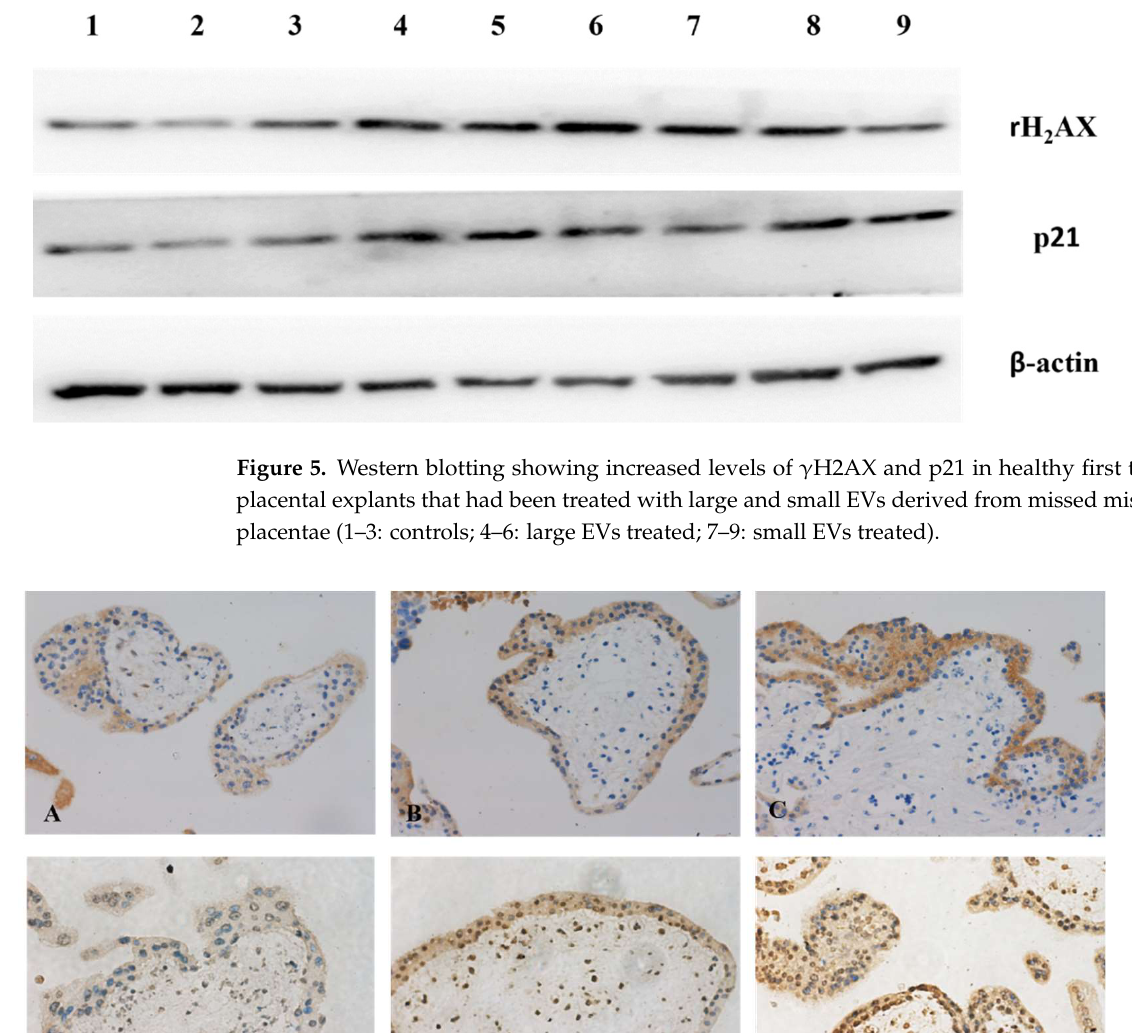
10 of 15 Figure 4. ( A – G ): The levels of senescence-associated miRNAs in missed miscarriage placentae (data represents mean ± SD with five repeats). 3.7. Treatment with a Single miRNA Did Not Affect the Growth of Trophoblasts and Did Not Induce the Senescent Changes To investigate the functions of the aberrant miRNAs on senescence that is associated with the pathogenesis of missed miscarriage [8], HTR-8/SVneo cells were transfected with a mimic of miRNA-125-1-3p, to imitate upregulation, as seen in EVs derived from the placenta of missed miscarriage. HTR-8/SVneo cells were also transfected with an inhibitor of miRNA-512-3p to imitate downregulation, as seen in EVs derived from the placenta of missed miscarriage. The growth of HTR-8/SVneo cells after transfection with a mimic of miRNA-125-1-3p or an inhibitor of miRNA-512-3p or a combination of mimic and inhibi- tor was not changed after 48 h treatment, compared to untreated cells (Data not shown). In addition, there was no change in the levels of p21 and γH2AX, markers of senescence, in HTR-8/SVneo cells that had been transfected with a mimic of miRNA-125-1-3p, or an inhibitor of miRNA-512-3p, compared to untreated cells (Data not shown). 3.8. Placental EVs from Missed Miscarriage Induced Senescent Changes in Normal Placentae It is well-known that EVs can be re-uptaken by the original cells [23,24]. To under- stand whether there is an autocrine effect of EVs from the placentae of missed miscarriage on inducing senescence, normal placental explants were treated with EVs derived from